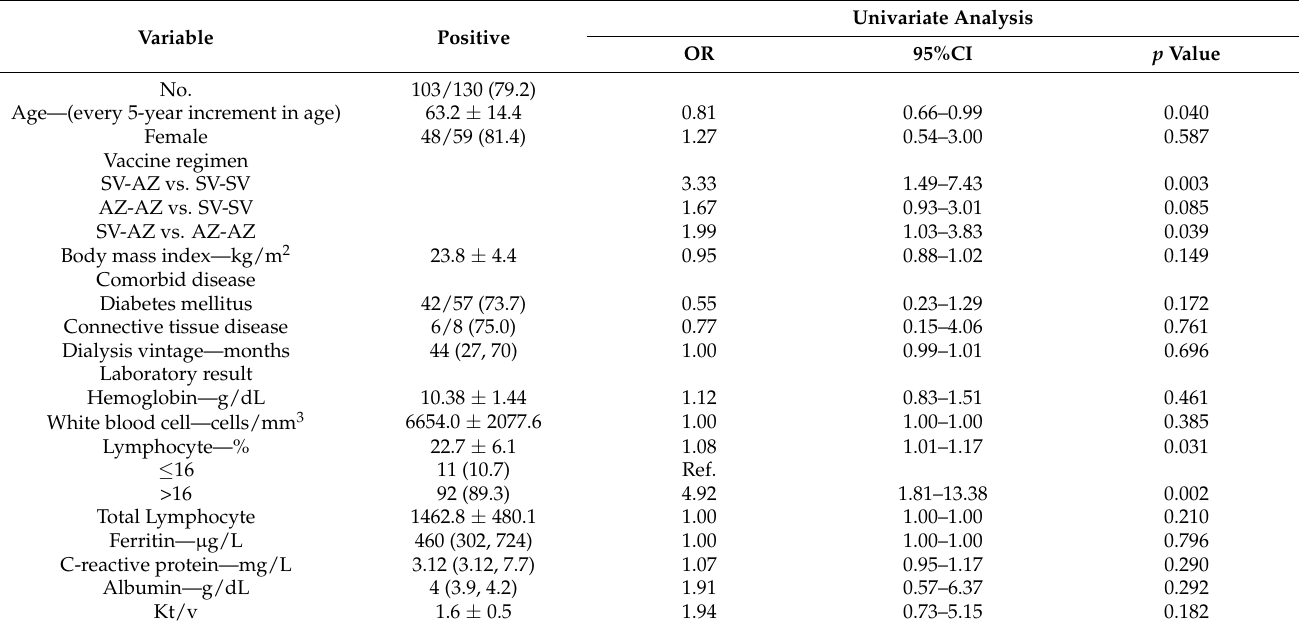
Table 2. Univariate analysis of factors associated with the seroconversion measured by sVNT among maintenance hemodialysis patients.